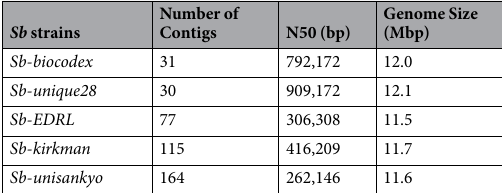
Table 1. Genome Assembly statistics of all Sb